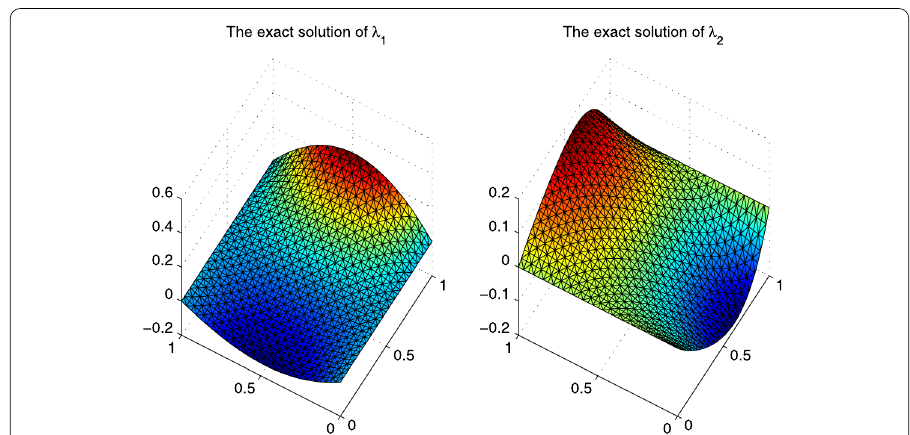
Figure 4 The exact solution of λ = ( λ 1 , λ 2 ).